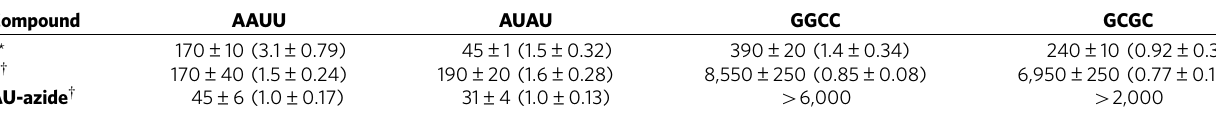
Table 1 | EC 50 s (nM) and Hill coefficients (shown in parentheses) of compounds binding to the base paired RNAs shown in Fig. 1. Compound